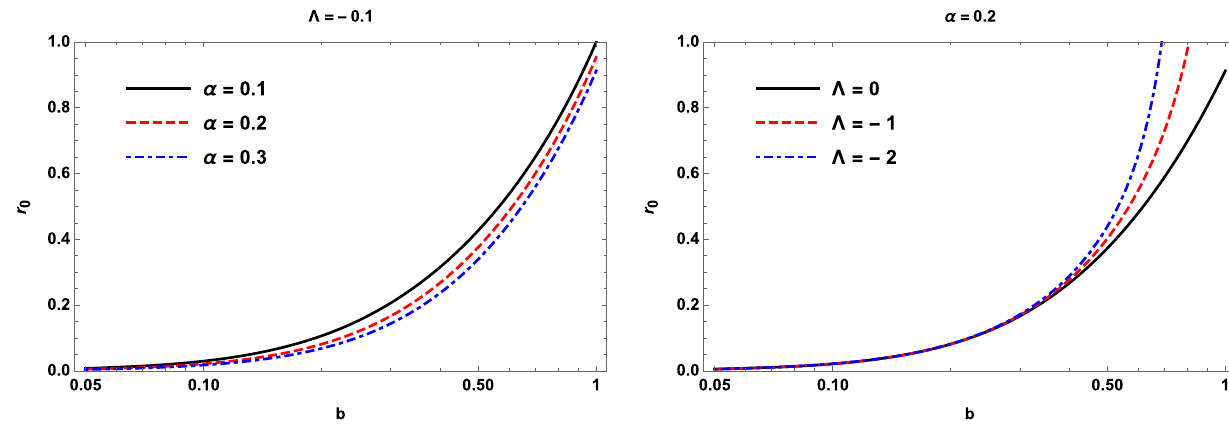
Fig. 5 The dependence of the distance of closest approach of a photon on the impact parameter b